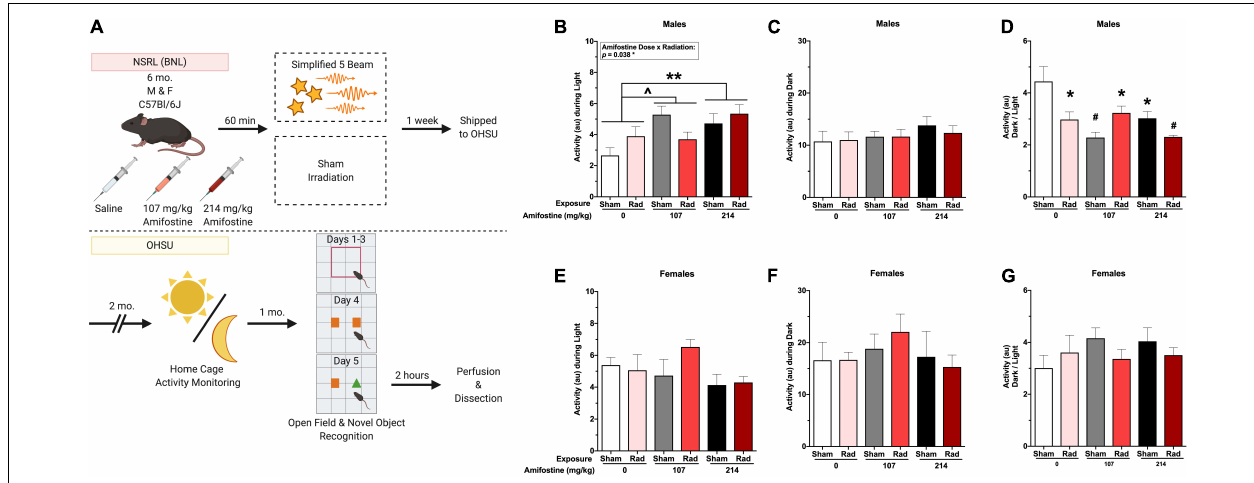
FIGURE 1 | Experimental timeline and home-cage activity data. (A) Six-month-old male and female C57Bl/6J mice received an injection of saline, 107 mg/kg, or 214 mg/kg of amifostine 60 min before exposure to the simplified five-beam simulated galactic cosmic rays or the sham hotel. Mice were then shipped to the authors’ institution. Two months following exposure, home-cage activity was recorded for 1 week. After another month, mice underwent open field and novel object recognition tests. Two hours following the novel object test, mice were euthanized, and tissue collected. (B–G) Home cage activity data. In male mice, we found a main effect of amifostine ( p = 0.010) and amifostine-by-radiation interaction ( p = 0.038) during the light cycle (B) . Mice injected with saline were significantly different than mice injected with 214 mg/kg ( p = 0.005) and trended toward different from 107 mg/kg ( p = 0.054). No differences in average dark activity were found in males (C) . There was an effect of amifostine ( p = 0.003) and amifostine-by-radiation interaction ( p = 0.002) when the ratio of activity during the dark to activity during the light was analyzed in male mice (D) . All groups were different than the Sham-Saline group. In female mice, there were no differences in average light activity (E) , average dark activity (F) , or the ratio (G) . Data are presented as means ± SEMs. ∧ p < 0.06; * p < 0.05; ** p < 0.01; # p <